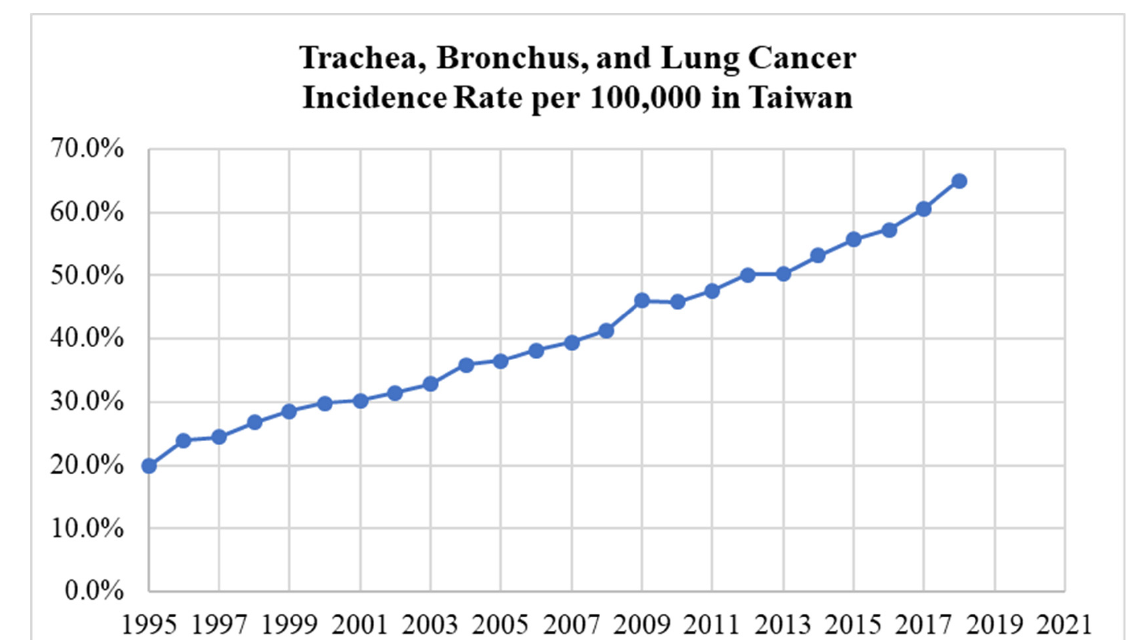
Figure 1. The trachea, bronchus, and lung cancer incidence rate in Taiwan.